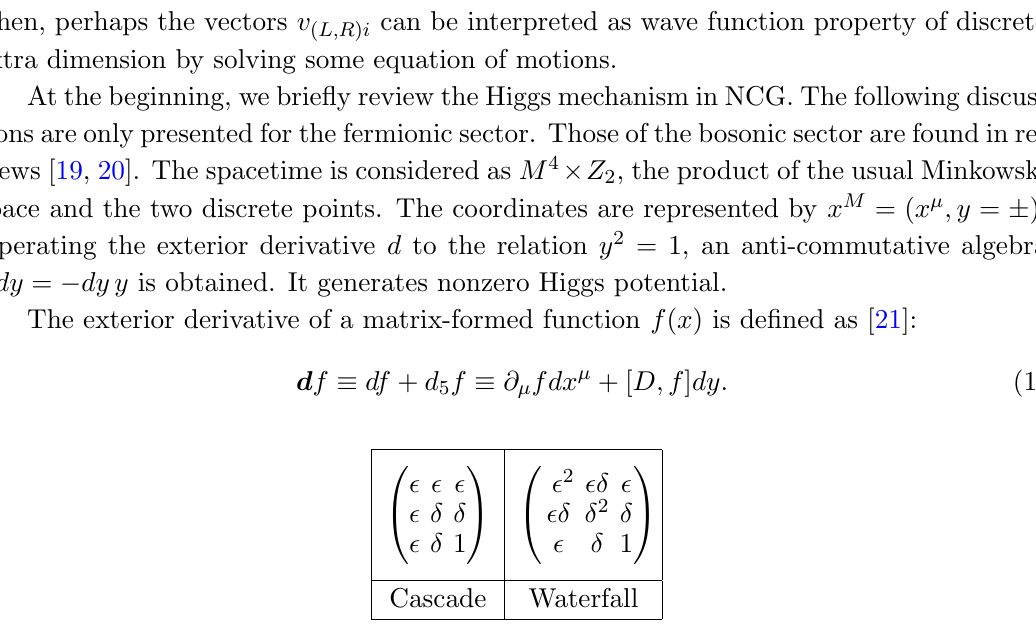
Table 1 . The cascade and waterfall texture, with 1 (cid:29) (cid:14) (cid:29) (cid:15)